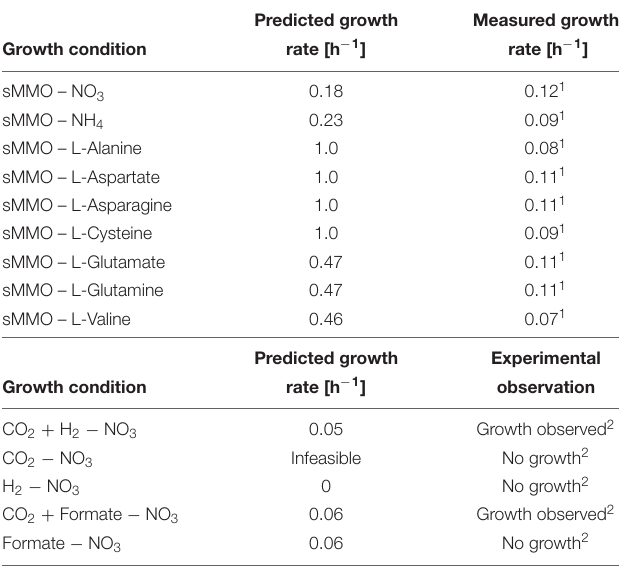
TABLE 1 | Model validation against experimental conditions from